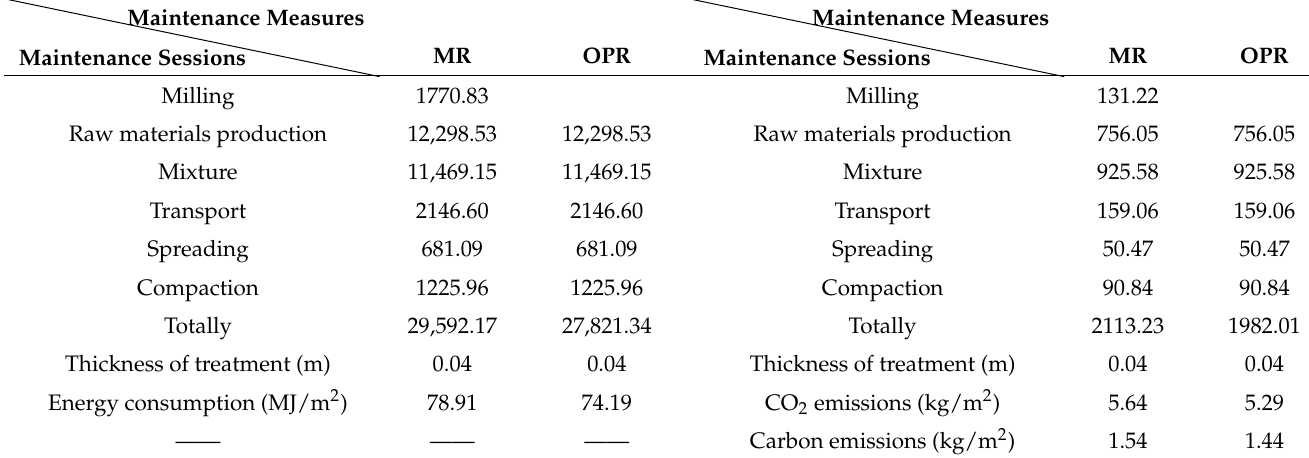
Table 10. The energy consumption (left) and carbon emissions (right) of the two maintenance measures